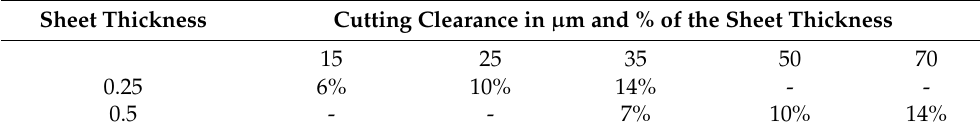
Table 3. Applied cutting clearances and the cutting clearance/sheet thickness ratios.